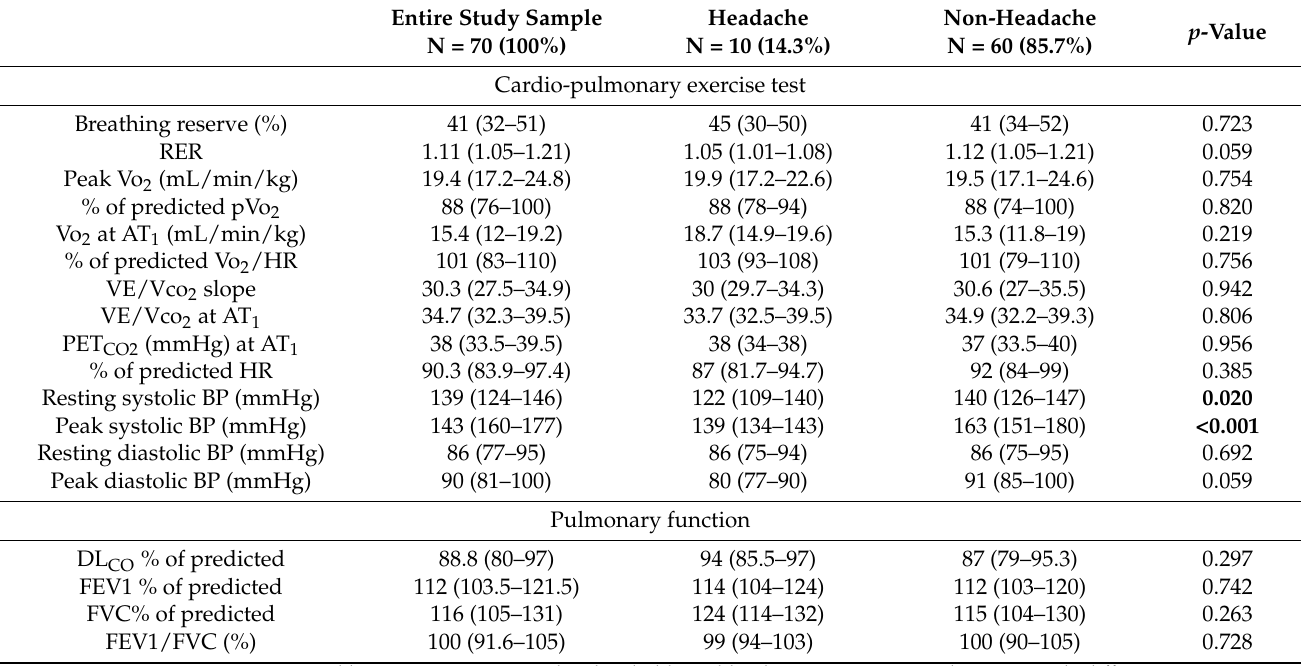
Table 3. Cardio-pulmonary evaluation of patients after SARS-CoV-2 infection according to the presence or absence of long-COVID headache during